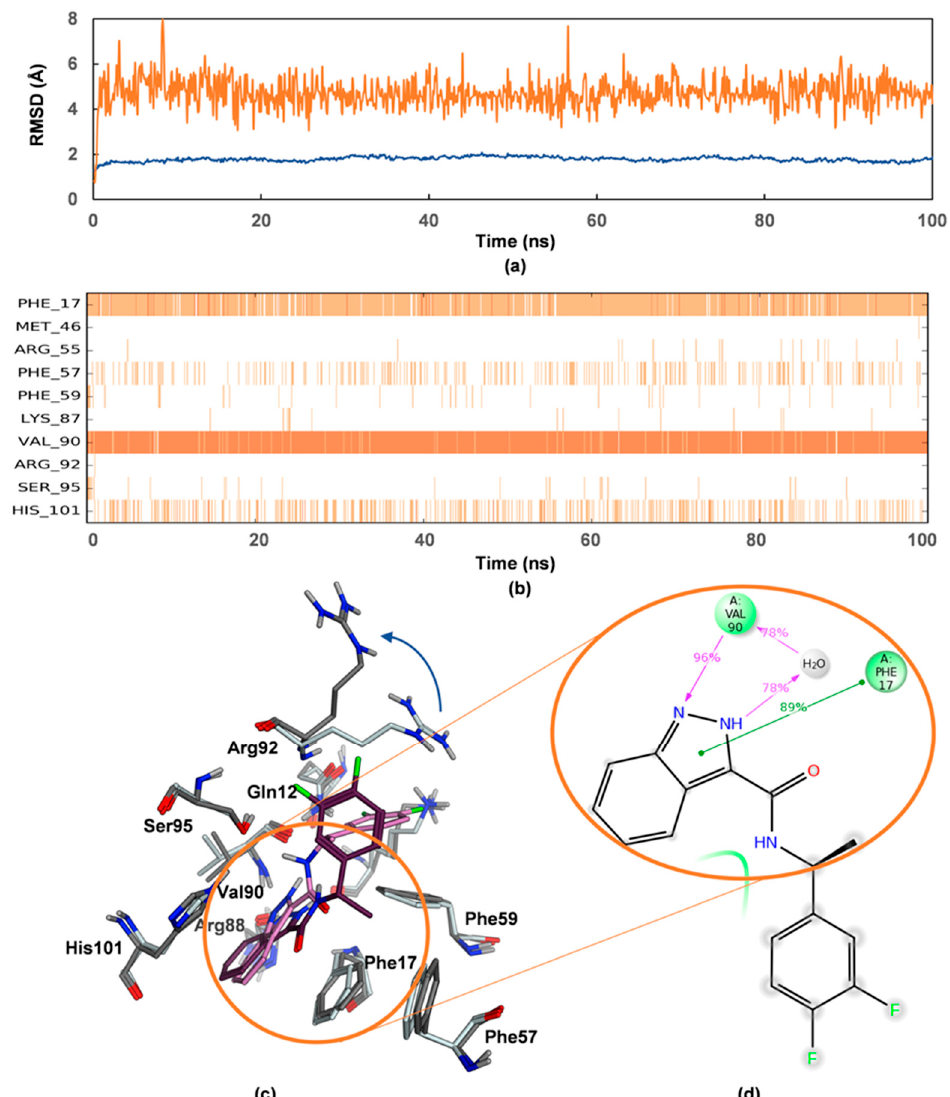
Figure 6. Dynamics of hnRNP A1-80051 complex during 100 ns MD simulations with explicit solvent. ( a ) RMSD displacement during the simulation trajectory of the protein side chains (blue) and of the ligand with respect to the protein (orange); ( b ) Protein-ligand contacts during the simulation time course. Val90 and Phe17 are main stabilizing residues with His101 and Phe57 seconding; ( c ) Three-dimensional superimposition of hnRNP A1 binding site and VPC-80051 at the beginning of the simulation and after 88.4 ns simulation time. Light grey and light magenta indicate the protein residues and the ligand in the reference frame while dark grey and dark magenta indicate the residues and the ligand in the selected 88.4 ns snapshot. The blue curved arrow indicates the larger movement of Arg92 side chain during the simulation; ( d ) Two-dimensional schematic of detailed interactions between VPC-80051 atoms with the protein residues. Stabilization of the ligand occurs via hydrogen bonding and water bridges with Val90 (purple arrow pointed lines) and π - π interactions with Phe17 (green lines). The percentages indicate the strength of ligand-protein interactions.